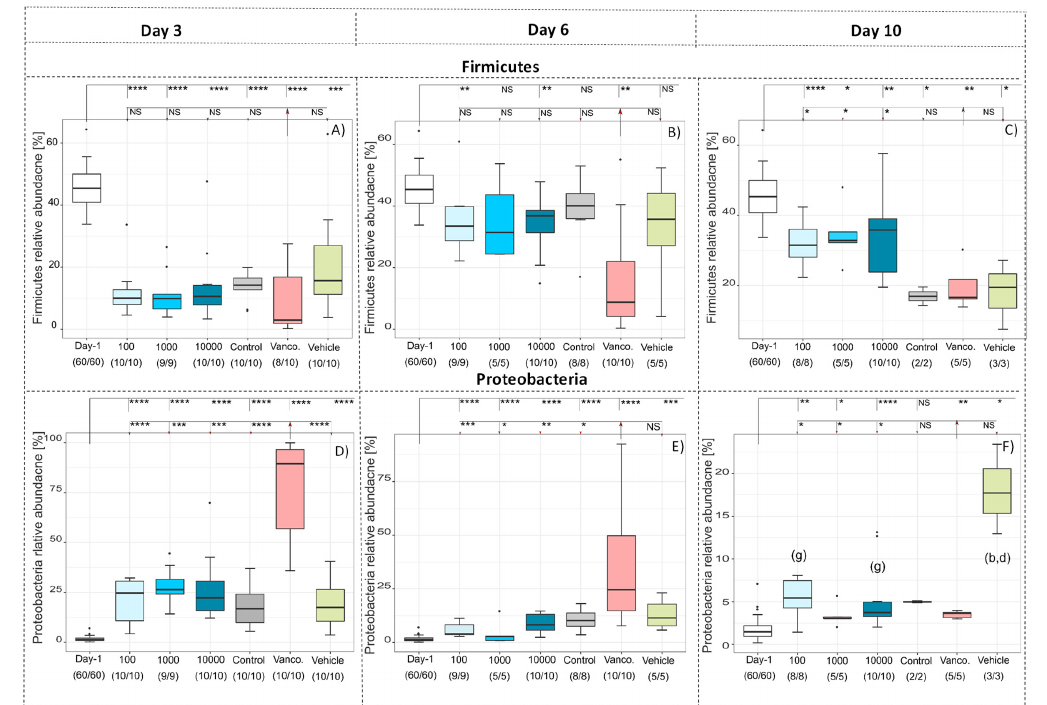
Figure 2. Relative abundance at phylum level of Firmicutes ( A – C ), Proteobacteria ( D – F ) after 3 ( A , D ), 6 ( B , E ) and 10 ( C , F ) days at indicated treatment compared to the relative abundance before treatment (day -1). Significance compared to before treatment and vancomycin values are p < 0.05 = *, p < 0.01 = **, p < 0.001 = ***, p < 0.0001 = ****, NS = not significant. Significant differences between the groups are marked by small letters.